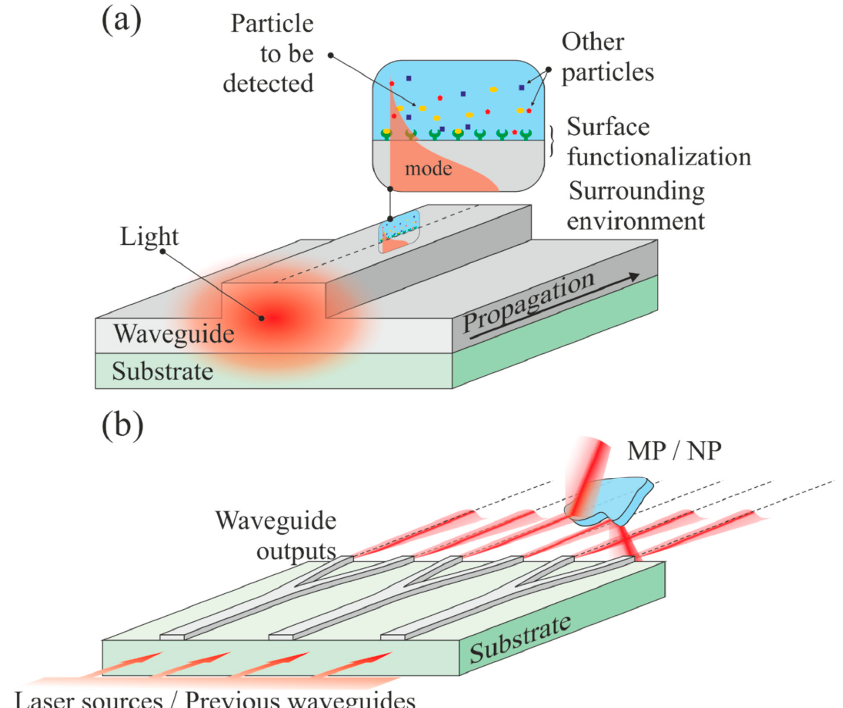
Figure 12. Waveguide-based sensors/detectors. ( a ) The top surface of a waveguide can be functionalized to attract specific molecules. The exponentially decaying portion of the propagating mode is interacting with the trapped particles, which yields a signal modification; ( b ) multiple channel waveguides illuminate a sample (which can be very large), which can reflect, deflect, or diffract the beams.